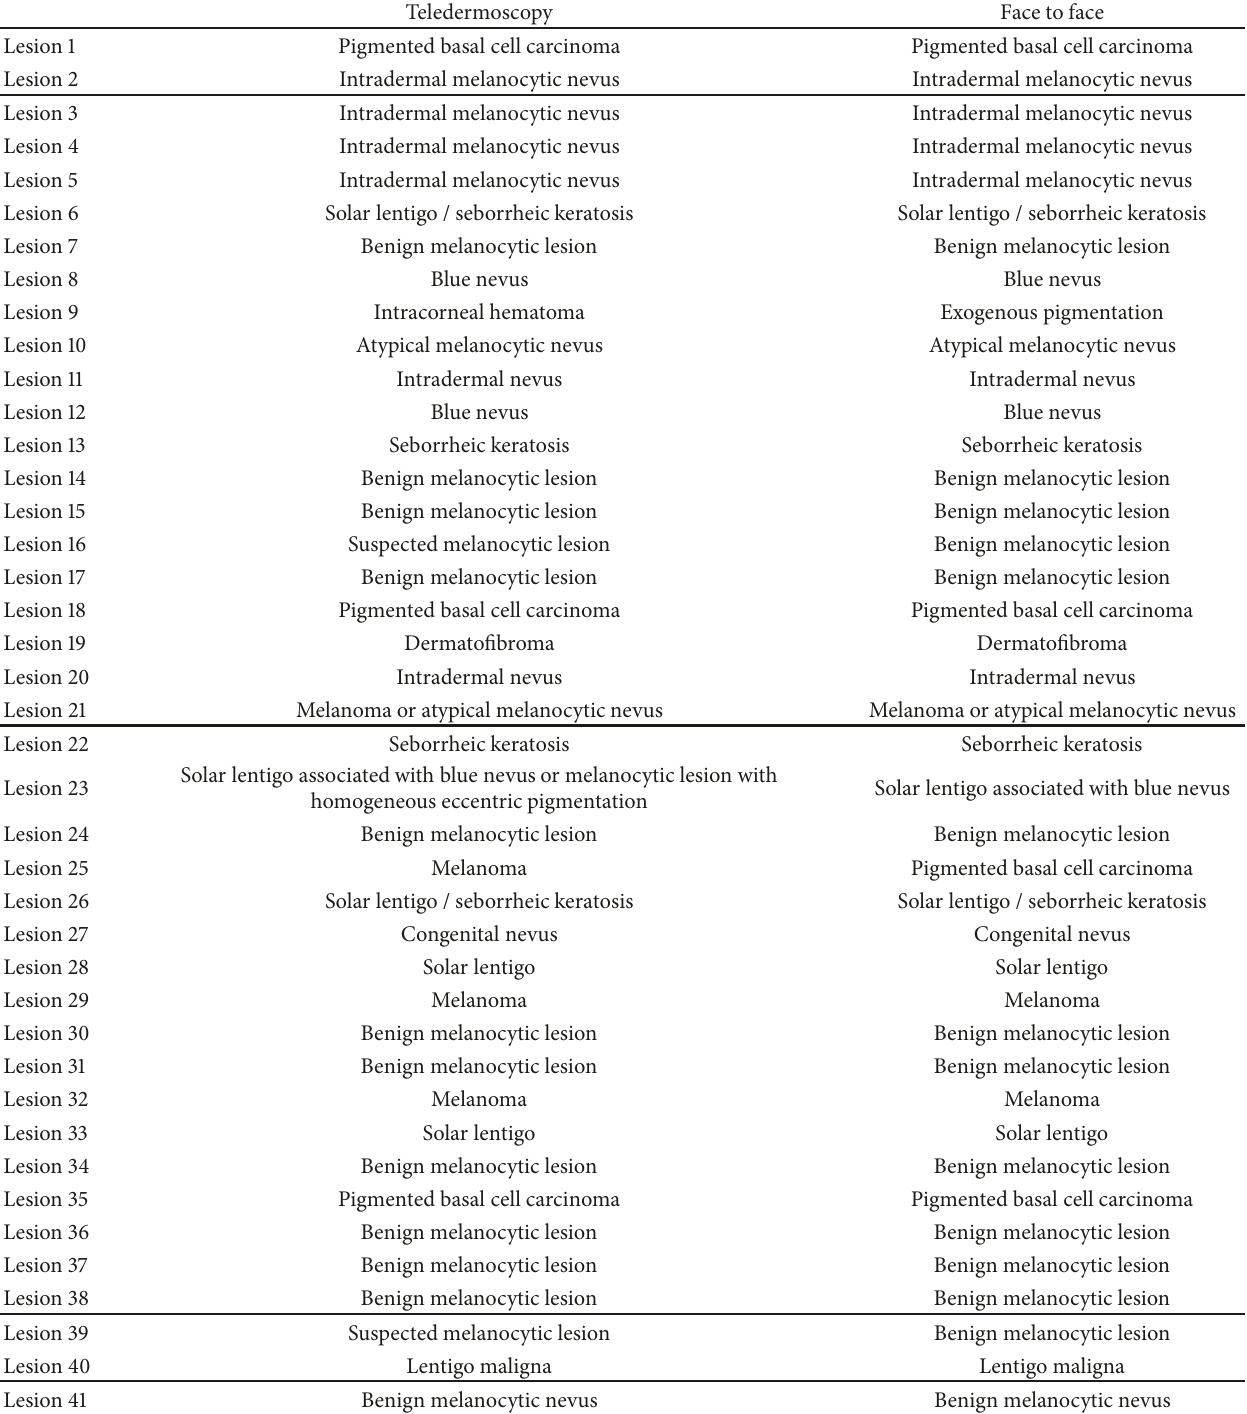
Table 1: Teledermoscopic and face-to-face